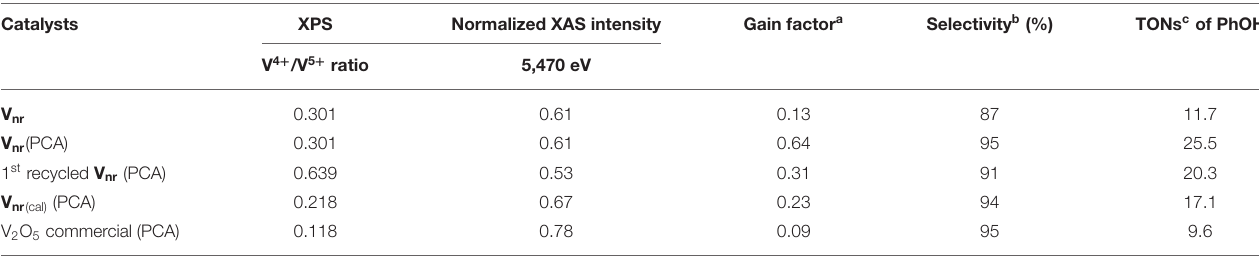
TABLE 1 | The summary of X-ray photoelectron spectroscopy (XPS) and X-ray absorption spectroscopy (XAS) data of vanadium oxide catalysts including V nr and its reactivity parameters.